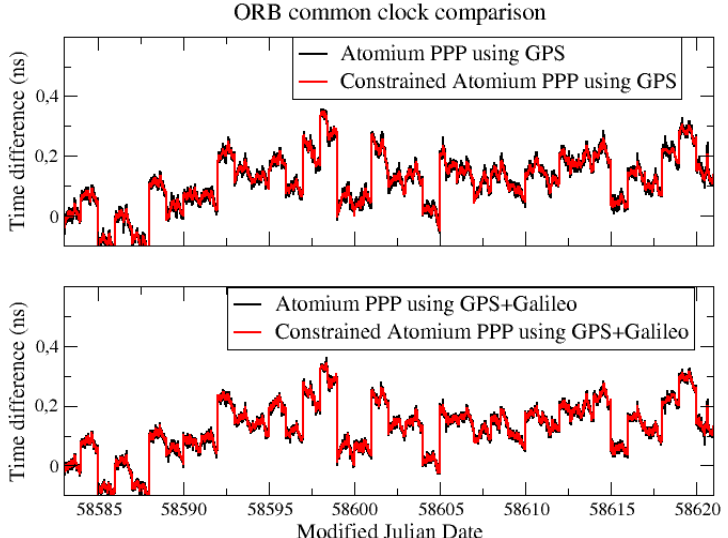
Figure 5. CCD constrained results in ORB.